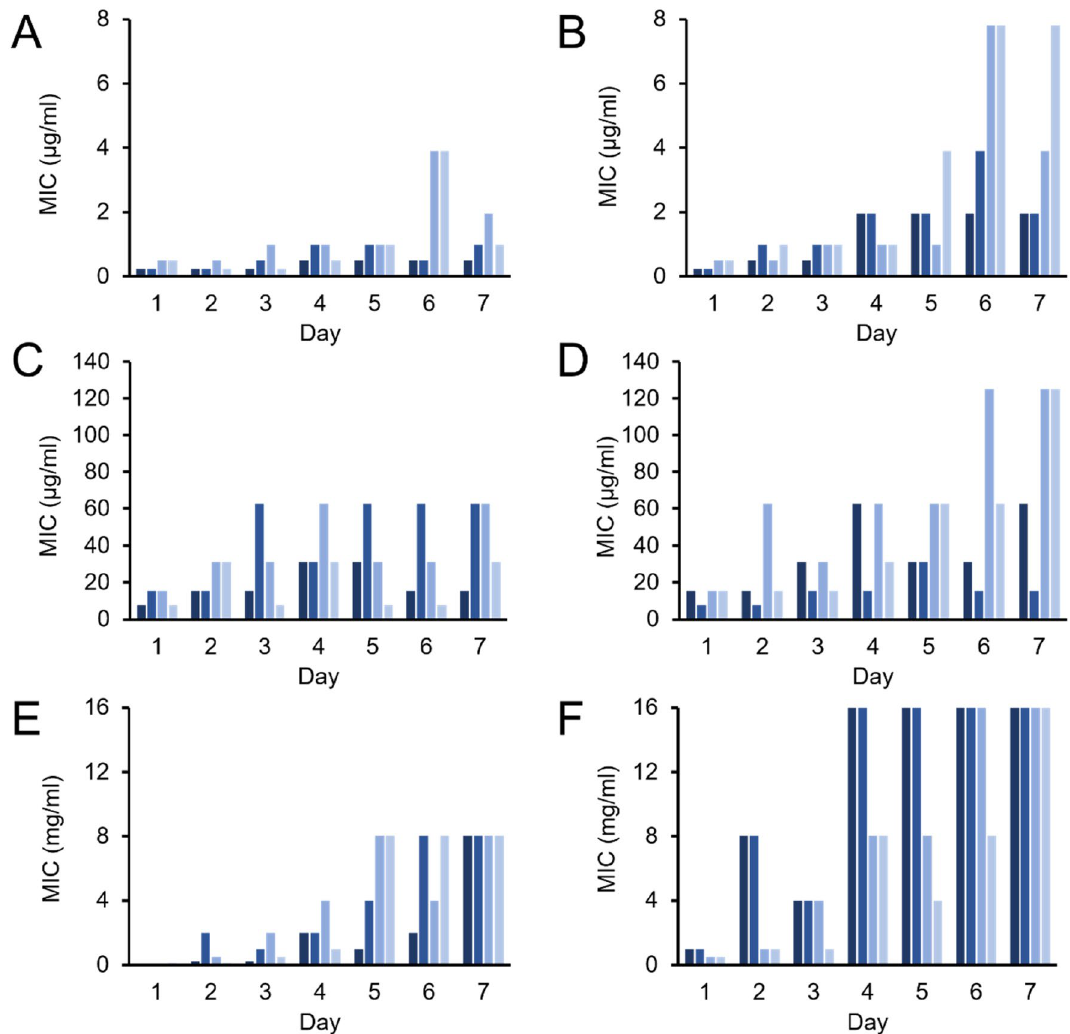
Figure 7. Effect of BING on the development of antibiotic resistance. Each bar represents one of the four replicates in each experiment. Bacteria (panels A – D : E. coli , panels E , F : P. aeruginosa ) were cultured in an increasing concentrations of antibiotics and cells survived at the highest antibiotic concentration were passaged daily for 7 days. Data here show the MIC of the selected cells on each day. ( A ) E. coli treated with kanamycin in the presence of BING (3.9 µg/mL). ( B ) E. coli treated with kanamycin alone. ( C ) E. coli treated with ampicillin in the presence of BING (3.9 µg/mL). ( D ) E. coli treated with ampicillin alone. ( E ) P. aeruginosa treated